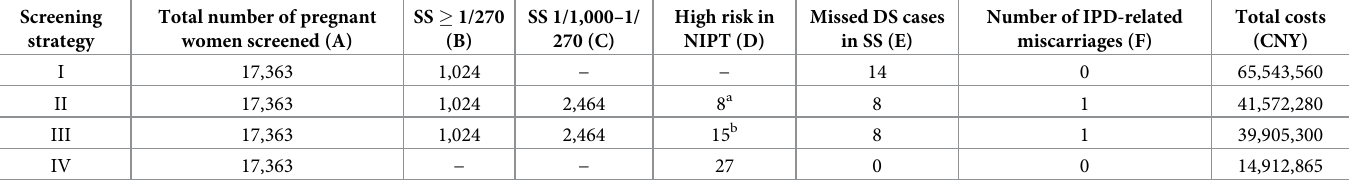
Table 4. Costs of DS screening with four screening strategies. Screening